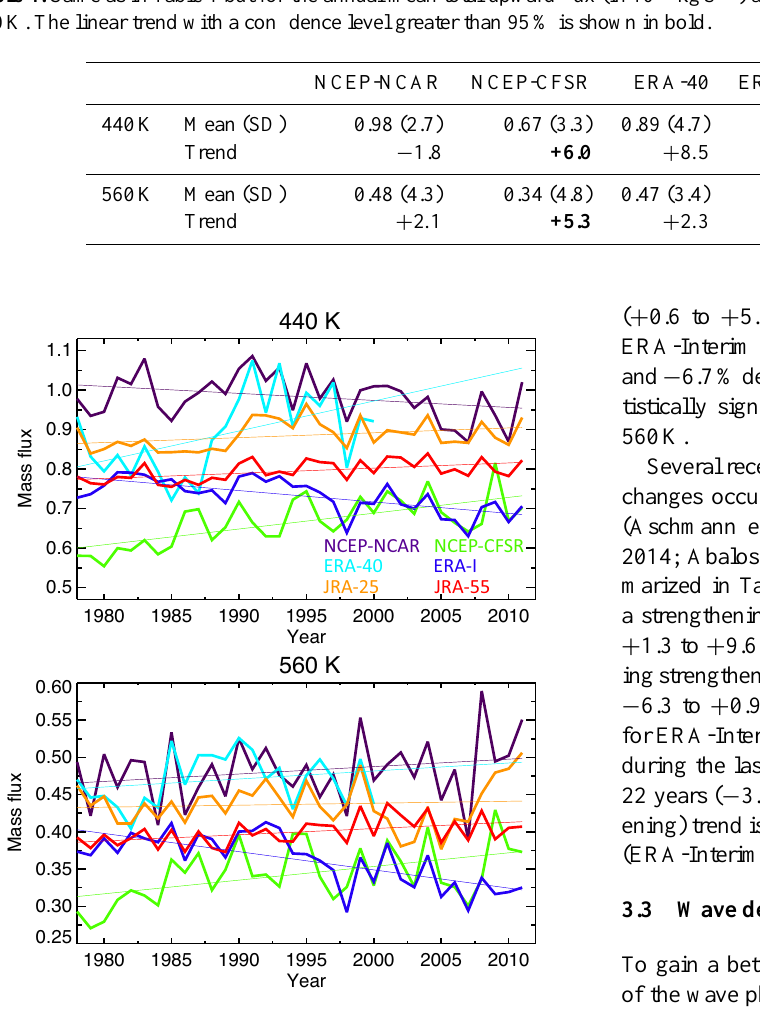
Table 4. Same as in Table 1 but for the annual mean total upward flux (in 10 10 kgs − 1 ) and its linear trend slope (in %decade − 1 ) at 440 and 560K. The linear trend with a confidence level greater than 95% is shown in bold.